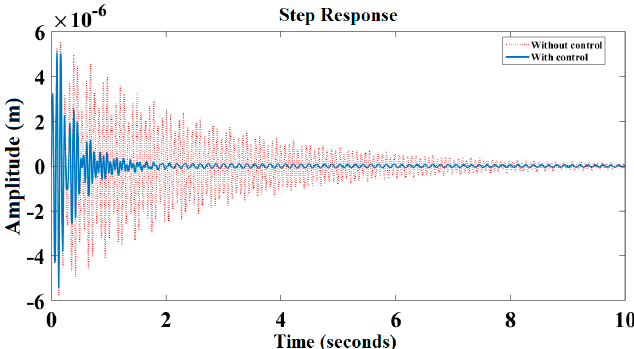
Figure 16. Impulse response of the beam (Sensors in FE4, Q = 10 10 , R = 1, Gc = 100).